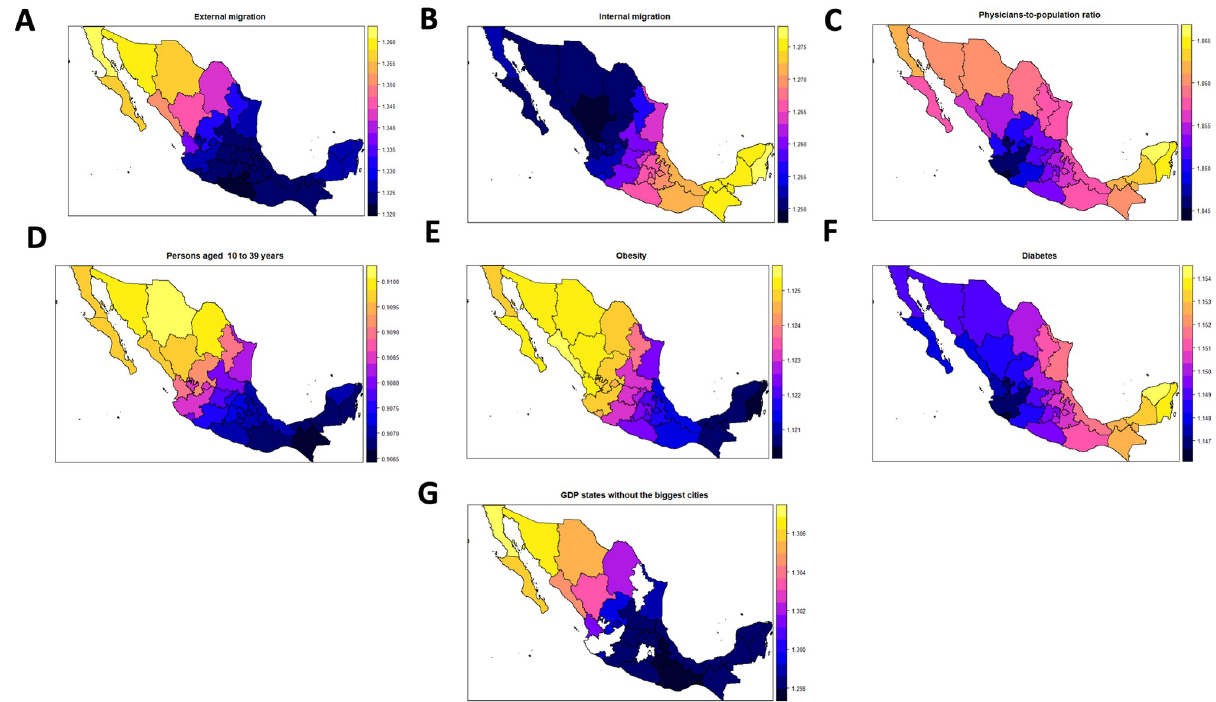
Fig 4. Multiplicative estimated effects over the tested mortality risk due to COVID-19 among tested individuals (MRt) under a GGWR for those variables that are significantly associated with the response under a global model (Poisson models with offset and a logarithmic link function). Shapefile from http://tapiquen-sig.jimdo.com under a CC BY license, with permission from Carlos Efraı´n Porto Tapique´n, original copyright 2015. Note: (1) Offset: Log of the total number of people tested in a state; (2) Multiplicative changes in mortality risks (MRt) from the effects of different risk factors by